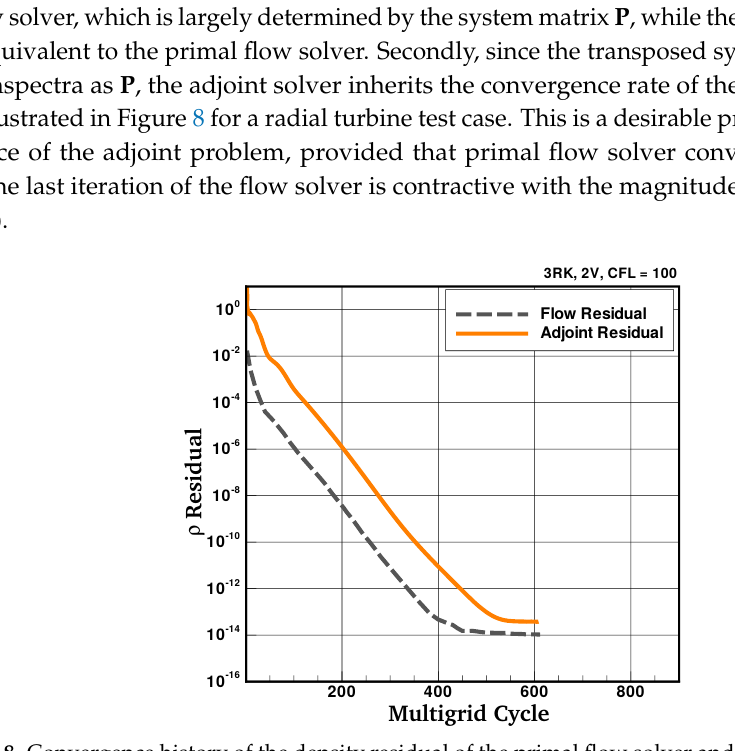
Figure 8. Convergence history of the density residual of the primal flow solver and of the adjoint solver for a radial turbine test